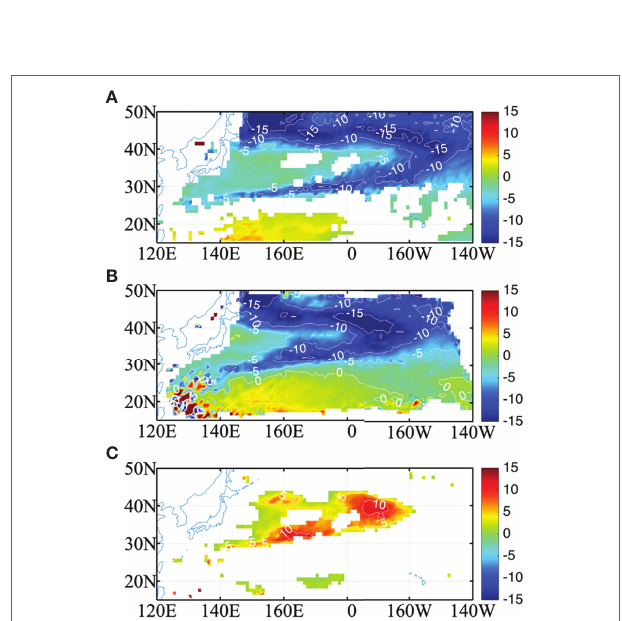
FIGURE 10 | The MLD difference (m) between the two experiments (CLIMCHL-NOCHL) in March of (A) the first year and (B) the second year. (C) is the difference between (A) and (B) (A, B) . The MLD differences in (A) are at 95% significant